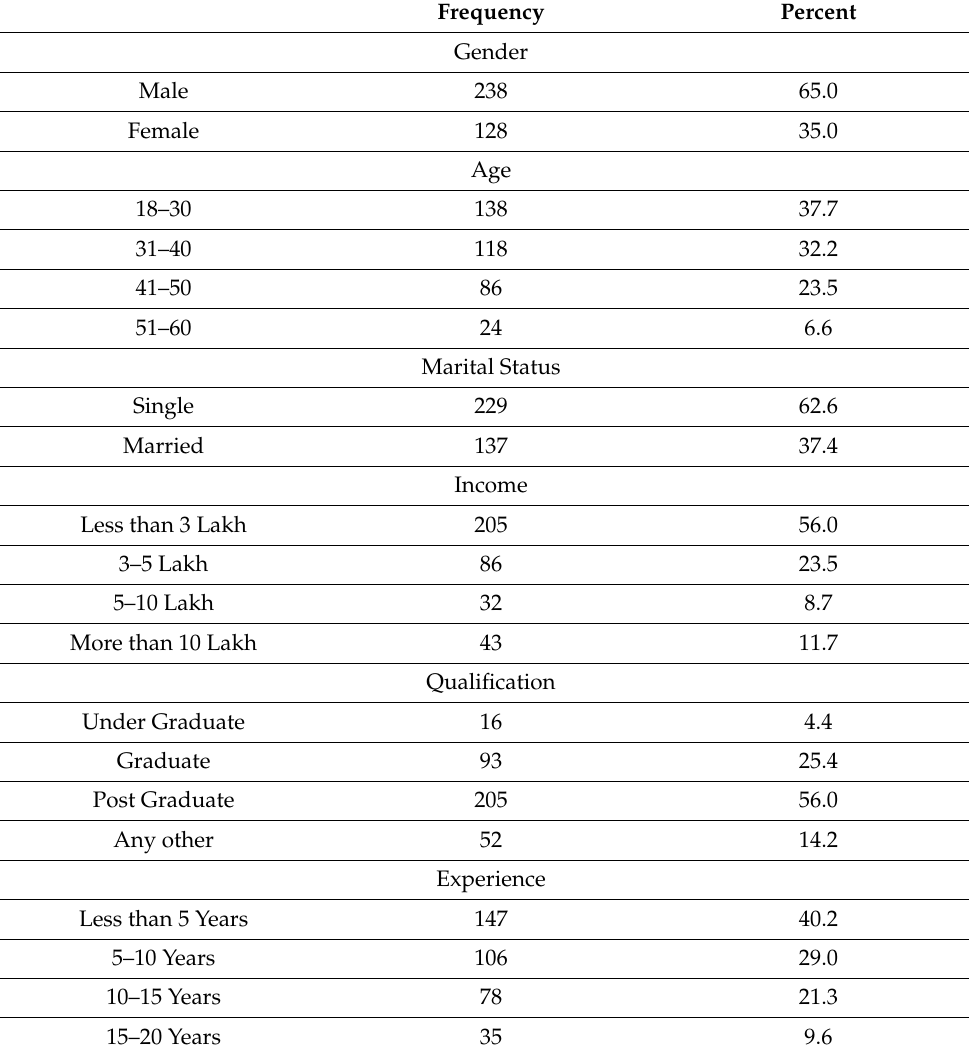
Table 1. Demographic